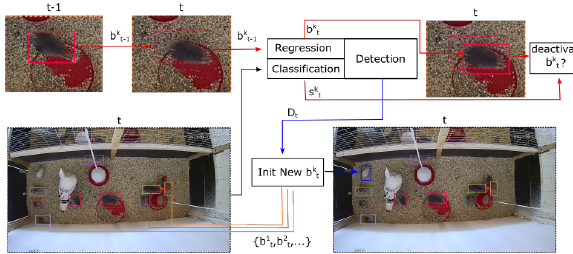
Figure 1. The proposed methodology performs simultaneous tracking of multiple animals using the tracktor approach. The two basic processing steps, bounding box regression and initialisation, are shown by red and blue arrows, respectively, for a single image at time t using an example from our poultry dataset. In the bounding box regression step, the object detector regression head adjusts the existing bounding boxes b k t − 1 of frame t − 1 to the new positions of the objects at frame t . The corresponding object classification scores s k t of the new bounding boxes are used to deactivate potentially occluded tracks. To determine whether a new bounding box has to be initialised, the Intersection over Union (IoU) is calculated between each element of the set of detections D t of frame t and the elements of the active tracks B t = { b 0 t , b 1 t , ... } . If the IoU between a detection and the bounding boxes of all active